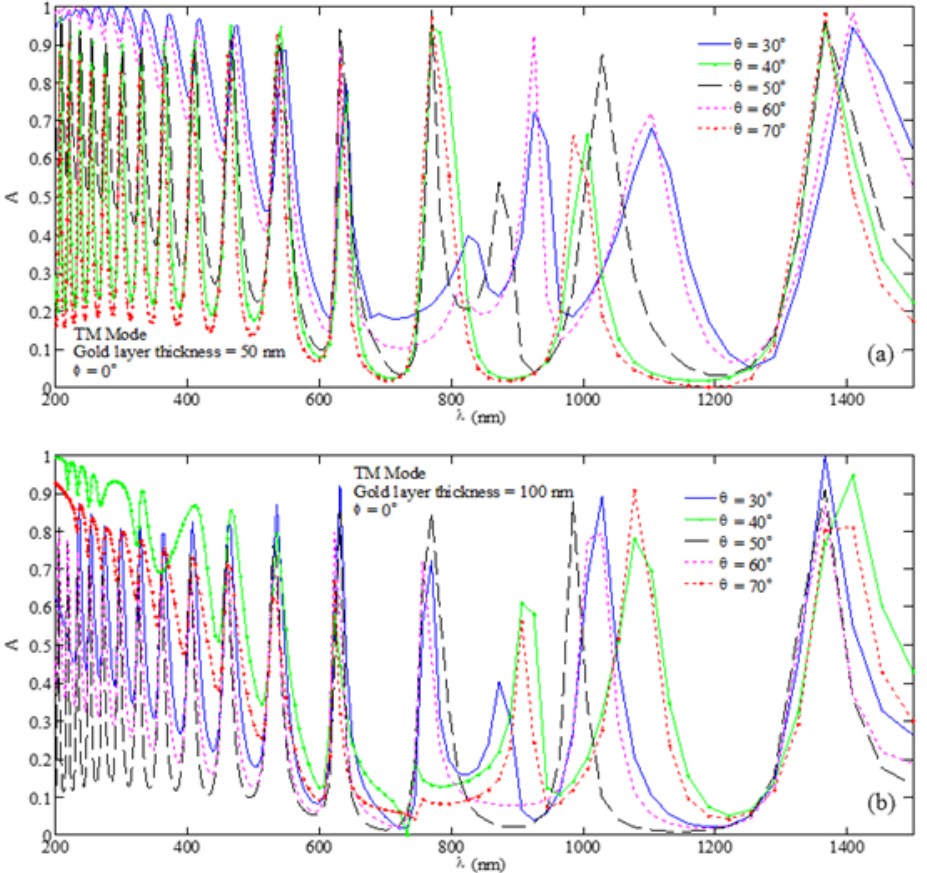
Figure 7. Absorption spectra for the butt-facing U-shaped MPA nanostructure under the TM wave excitation with ϕ = 0° incidence and corresponding to the cases of ( a ) 𝑑 = 50 nm and ( b ) 𝑑 = 100 nm with 𝑡 = 500 nm.